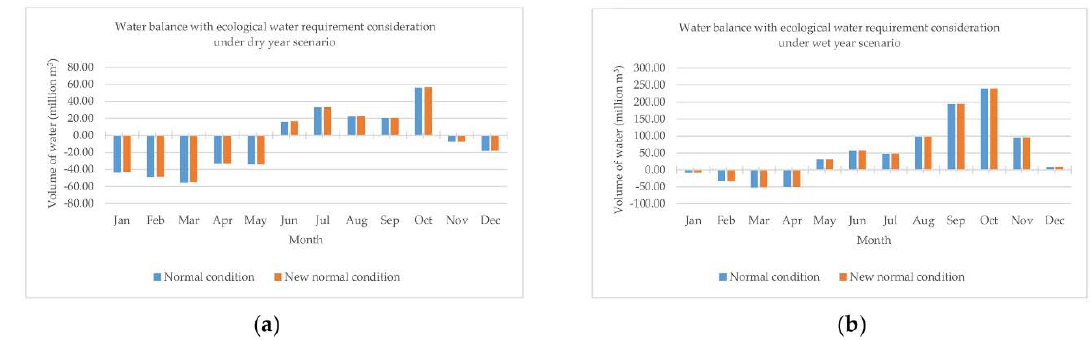
Figure 16. Monthly water balance with consideration of ecological water requirements under two scenarios in normal and new normal conditions: ( a ) dry year scenario; ( b ) wet year scenario.